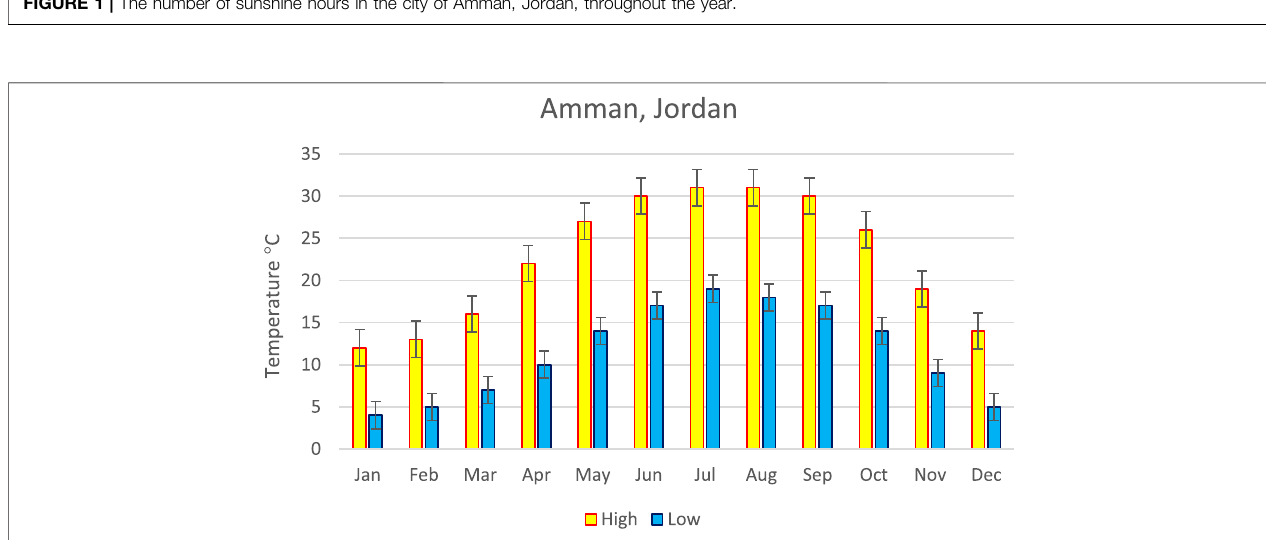
FIGURE 1 | The number of sunshine hours in the city of Amman, Jordan, throughout the year.